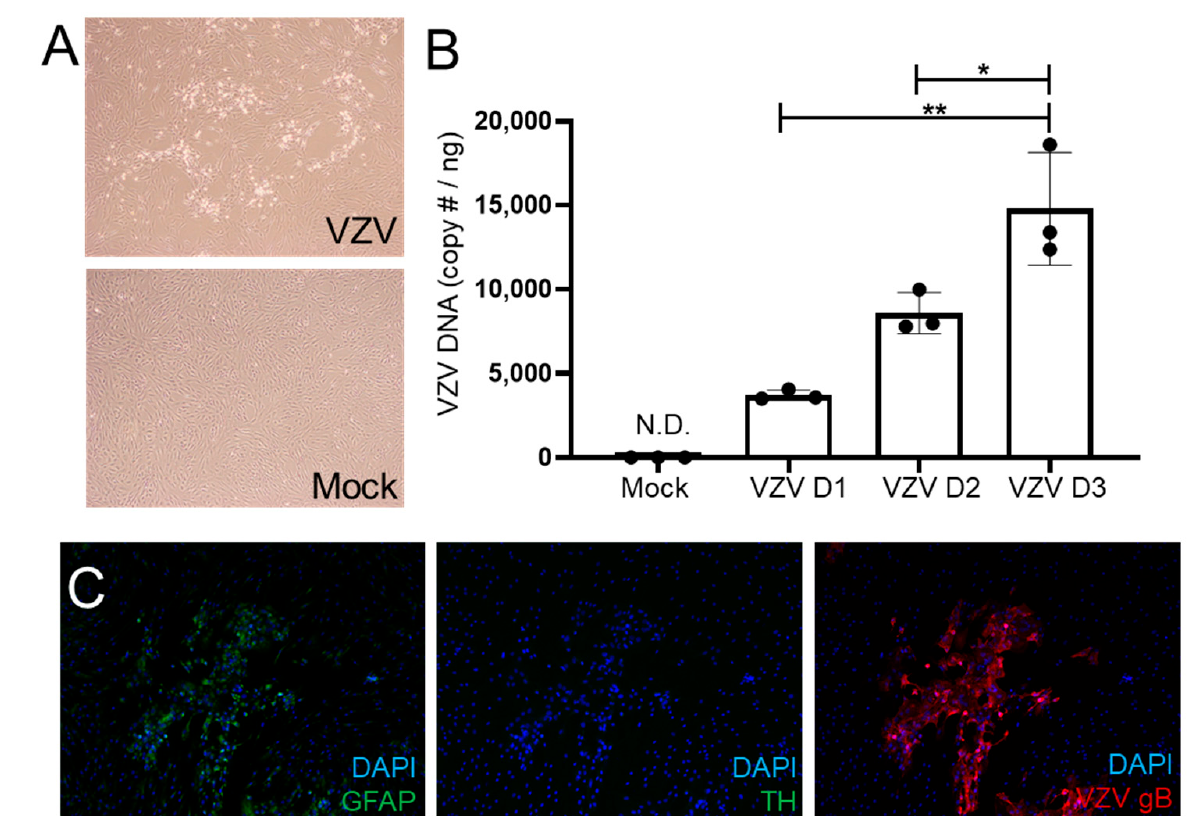
Figure 1. VZV productively infects quiescent human adrenal cortical cells (qHAdCCs). ( A ) At 3 days post-infection (DPI), VZV-infected qHAdCCs had a cytopathic effect that was absent in mock-infected cells on phase-contrast microscopy. ( B ) VZV DNA significantly increased over time at 1, 2, and 3 DPI; VZV DNA was absent in mock-infected cells at 3 DPI. ( C ) In VZV-infected qHAdCCs, adrenal cortical cell purity was confirmed by expression of glial fibrillary acidic protein (GFAP, left panel), but not tyrosine hydroxylase (TH; middle panel); cells expressed VZV glycoprotein B (gB, right panel), indicating productive virus infection in this cell type. Image magnification A = 4 × , C = 10 × . DAPI = nuclei dye; N.D. = not detected. * = p < 0.05, ** = p < 0.01. 3.2. VZV Infection of qHAdCCs Does Not Cause Cell Death Many non-neuronal cell types undergo cell death during VZV infection [11–16]. To examine whether VZV-infected qHAdCCs undergo cell death, mock- and VZV-infected qHAdCCs were fluorescently labeled with a TUNEL stain at 3 DPI (Figure 2A). There was no difference in abundance or intensity of fluorescent label between the two conditions. To further determine if apoptosis was occurring, we examined mock- and VZV-infected cell lysates with Western blot using antibodies against PARP and caspase 9. Cleaved caspase 9 and PARP are indicative of apoptosis (37 kDa and 89 kDa, respectively). No-to-minimal cleaved caspase 9 and PARP was seen in VZV-infected cell lysates, similar to that found in mock-infected lysates, indicating that VZV-infected qHAdCCs are not undergoing differing amounts of apoptosis over mock-infected cells. As a positive control for apoptosis, HLFs were treated with 1 µ M saurosporine; bands for both full length and cleaved caspase 9 and PARP were detected, indicative of apoptosis. Taken together, these results demonstrate that qHAdCCs are resistant to cell death during VZV